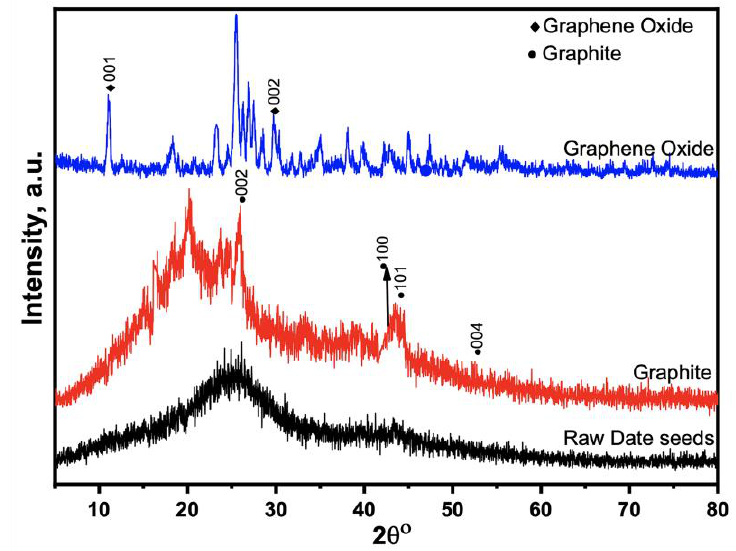
Figure 2. XRD patterns for raw seeds, graphite, and graphene oxide.